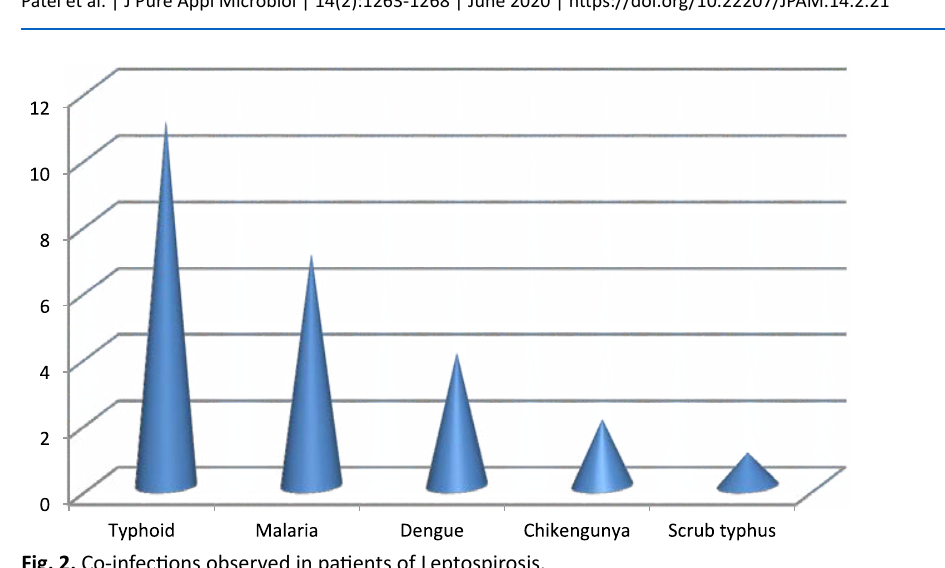
Fig. 2. Co-infections observed in patients of